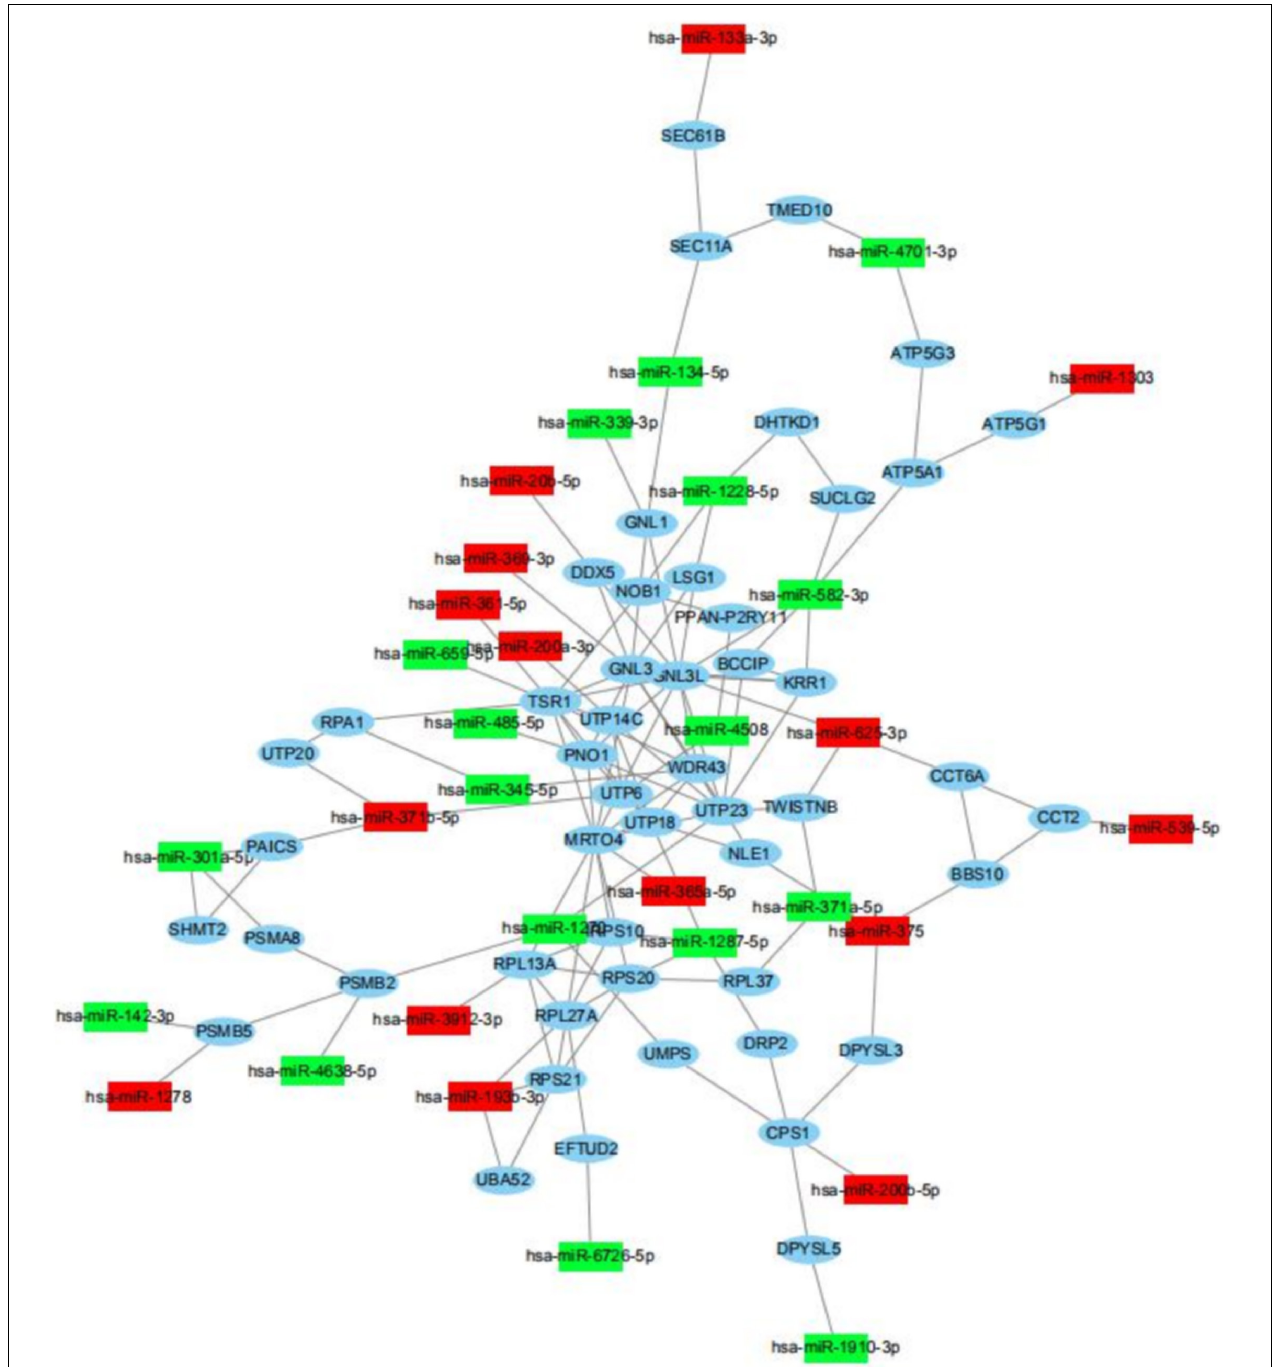
FIGURE 5 | miRNA-mRNA regulatory network between differently expressed miRNAs and target genes. View of miRNA-mRNA regulatory network according to miRNAs with differently levels and their regulated target